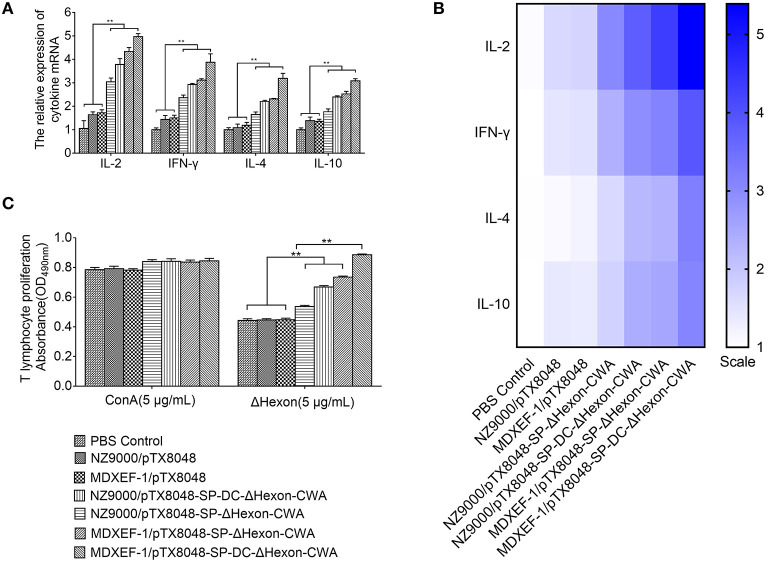
The mRNA expression levels of IL-2, interforn–γ (IFN-γ), IL-4, and IL-10 (A,B) in spleens of chickens in each group post-tertiary immunization and the proliferation of PBLs (C). (A) On 2-week post-tertiary immunization, the mRNA expression levels of IL-2, interforn-gamma (IFN-γ), IL-4, and IL-10 in spleens of five chickens in each group was determined by quantitative Real-time PCR (qRT-PCR). The mRNA levels of each chicken in each group were divided by mRNA levels of β-actin of the same chicken to normalize IL-2, IFN-γ, IL-4, and IL-10. (B) Heat map of the mRNA expression levels of IL-2, IFN-γ, IL-4, and IL-10 in chickens spleens. (C) PBLs of chickens (n = 5) in each group were isolated on 2-week post the third immunization. The proliferation of lymphocytes stimulated by ΔHexon protein or concavanalin (ConA) was detected by Cell Counting Kit-8 (CCK8) assay. Data are expressed as mean ± SD (n = 5). *p < 0.05, **p < 0.01. AST, aspartate transaminase; ALT, alanine transaminase; ALB, albumin; TP, total protein; and LDH, lactate dehydrogenase.